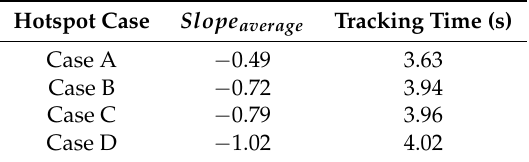
Figure 17. Simulation result for the proposed hotspot detection algorithm using a medium-scale PV array: ( a ) case A; ( b ) case B; ( c ) case C; ( d ) case D. Table 2. Numerical result for the proposed hotspot detection algorithm in